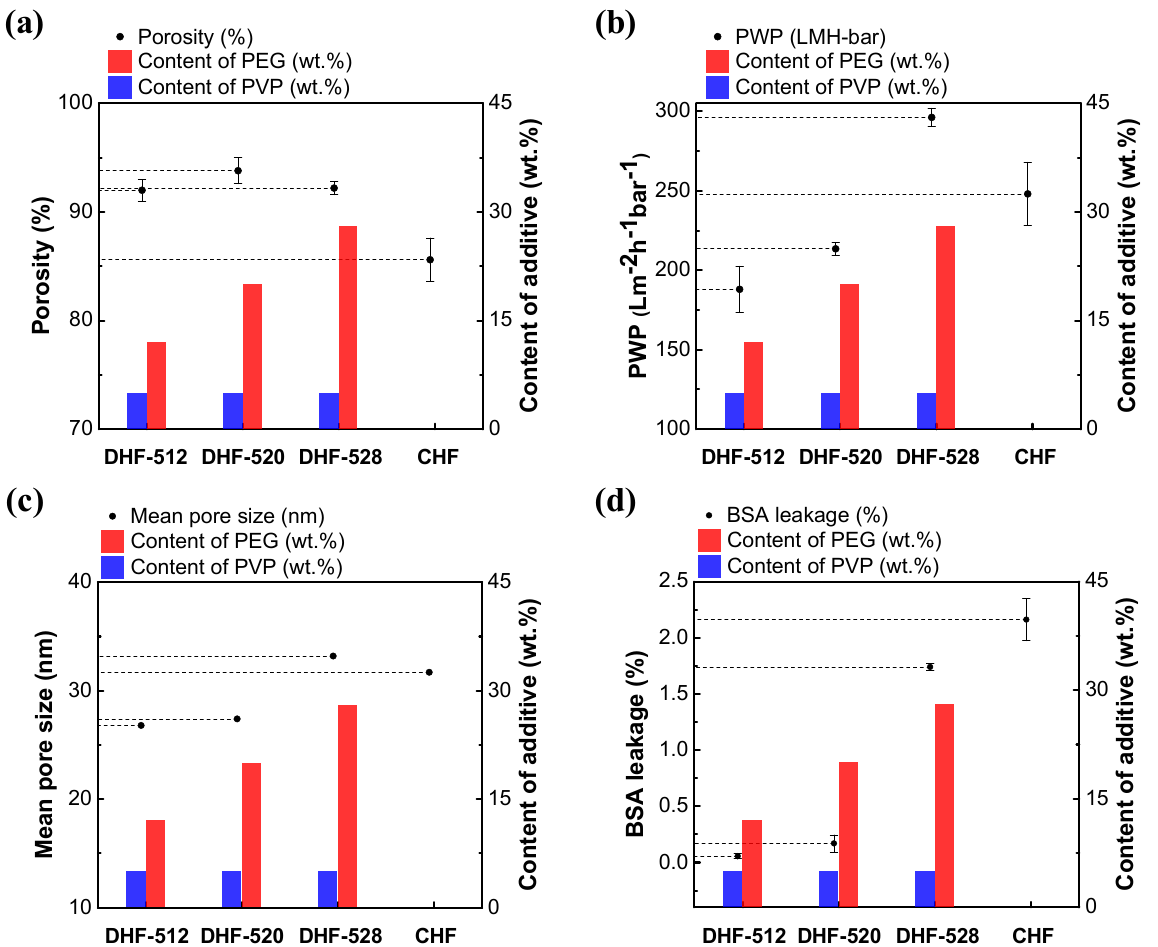
Figure 7. Comparison of membrane properties based on the contents of additives. ( a ) The porosity of DHFs and CHF. ( b ) Pore size of DHFs and CHF. ( c ). Pure water permeability (PWP) of DHFs and CHF. ( d ) BSA leakage of DHFs and CHF.